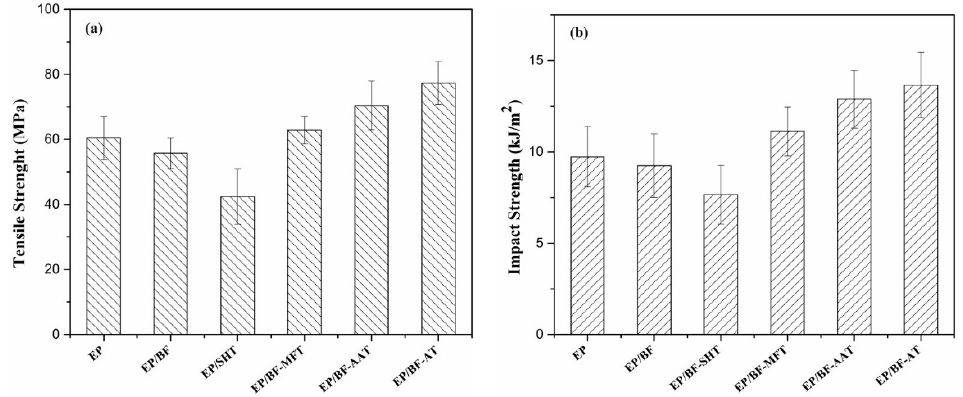
Figure 3. ( a ) Tensile strength, ( b ) unnotched impact strength behavior of epoxy-based composites.